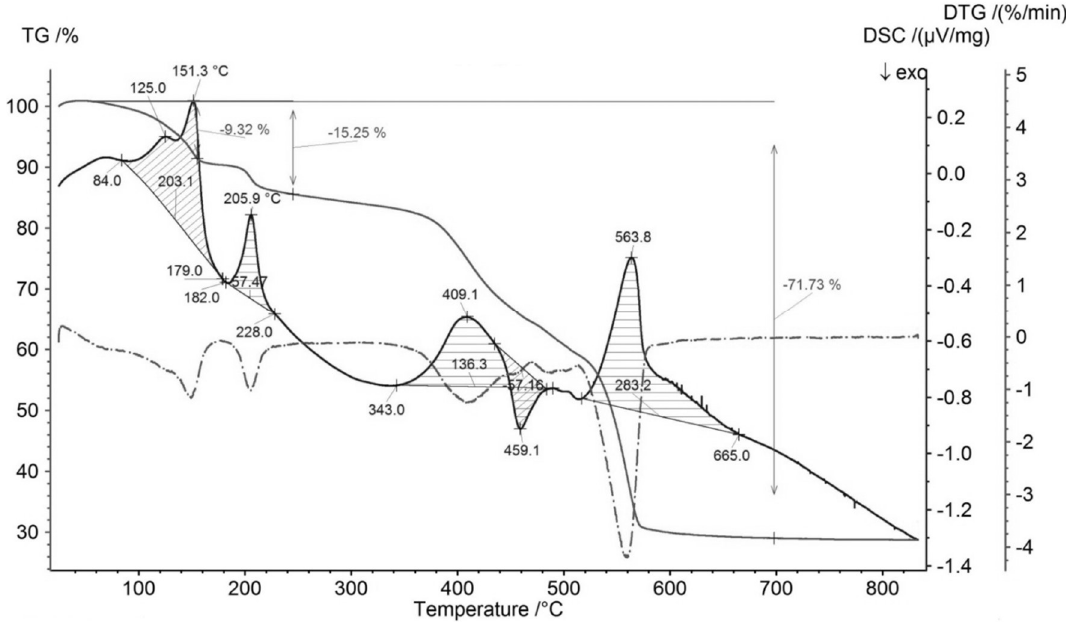
Figure 3. TG, DTG and DSC curves of synthesized analogue of mandarinoite (sample #9; 30 °C, 1.5 bar, 47 days) [8]. TG (gray solid line), DSC (black solid line), DTG (gray dashed line).